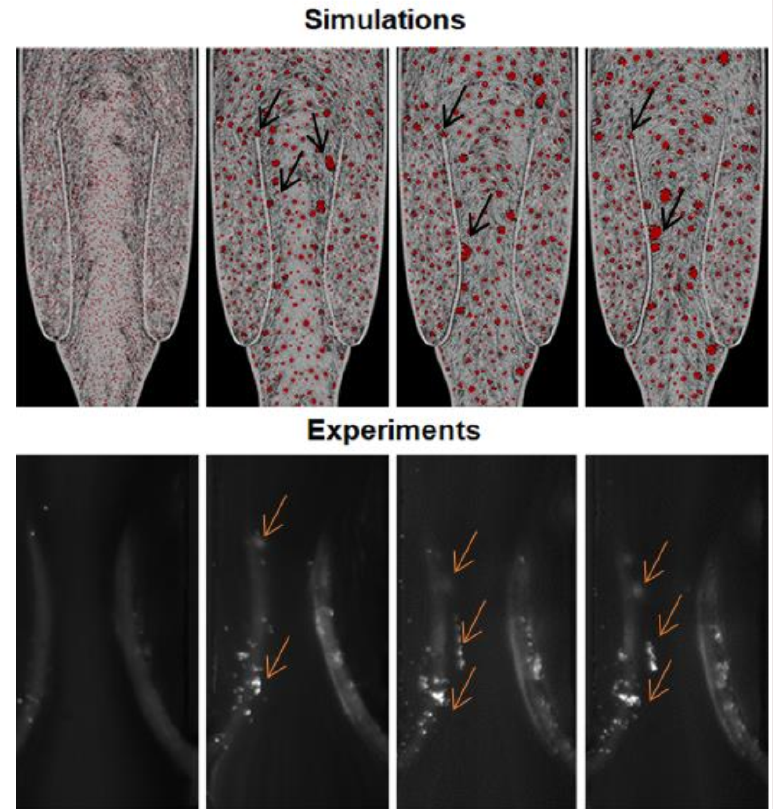
Figure 6. Simulation and experiment (platelets, fluorescently labelled, agglomeration in Schofield et al., 2020) snapshots illustrating the aggregates near the valve’s leaflet at different time points. The arrows indicate the aggregates near the valve